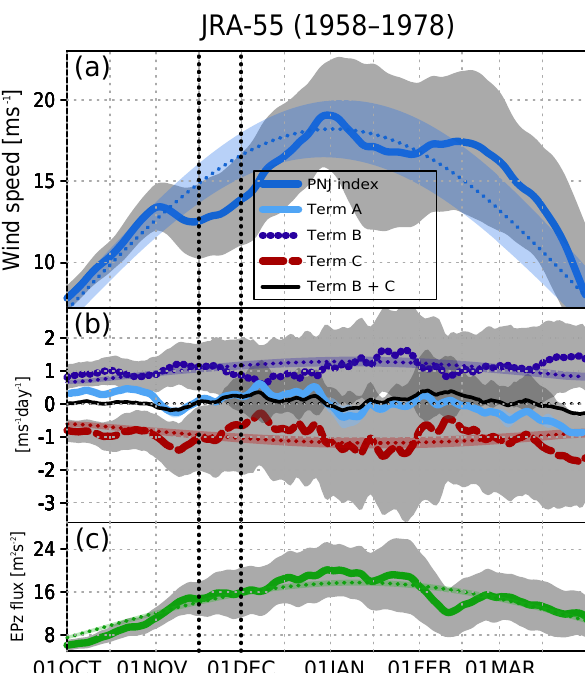
Figure A2. Same as Fig. 2, but for the 21-year average during 1958– 1978.